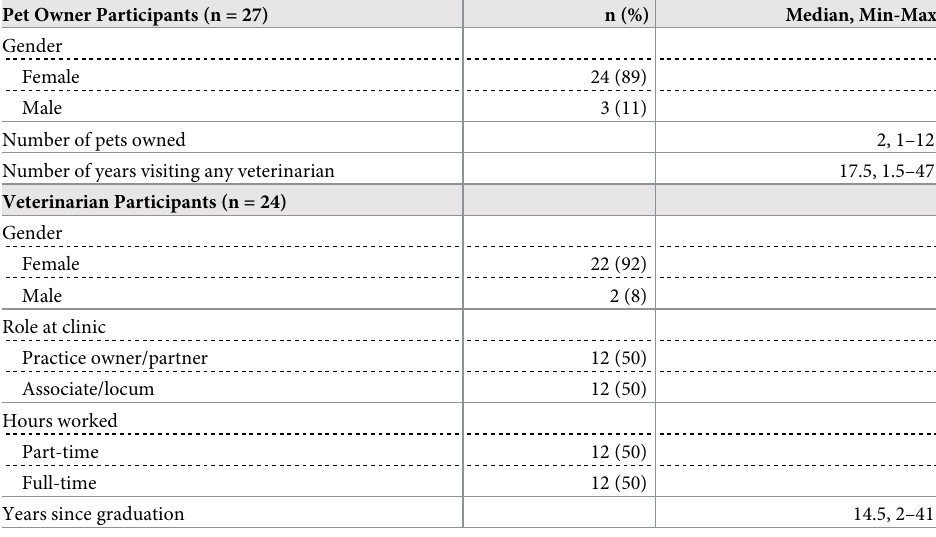
Table 2. Demographic characteristics of participating pet owners and